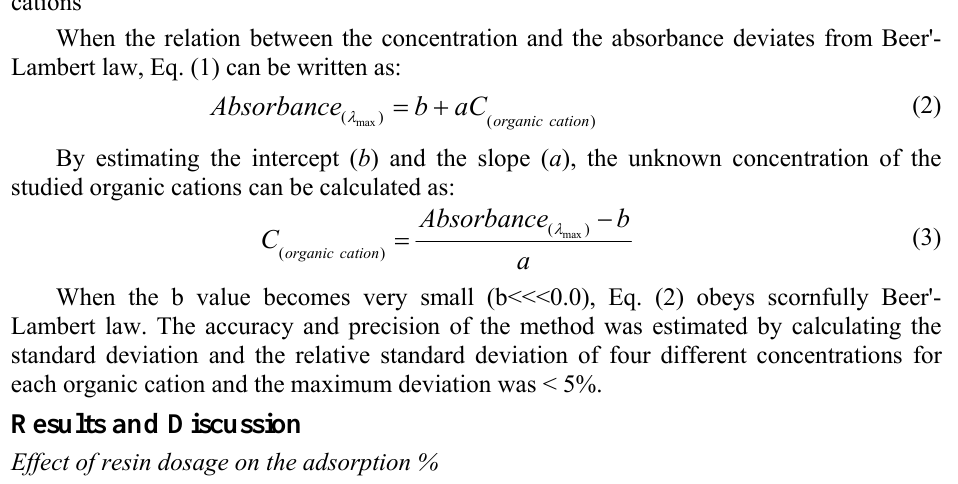
Figure 1 . The relation between the absorbance and the concentration of the studied organic